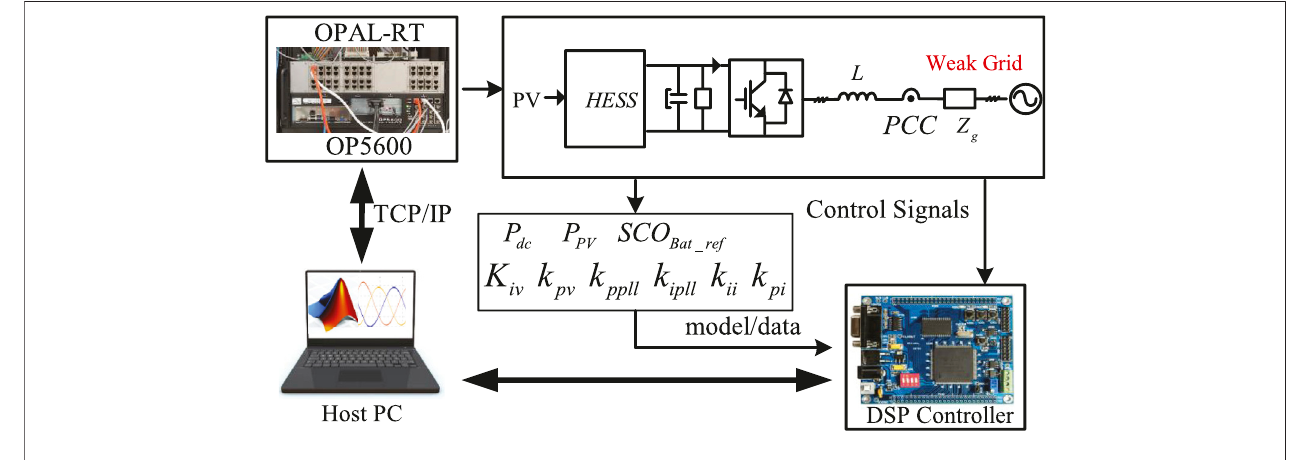
FIGURE 16 | HIL experiment topology.